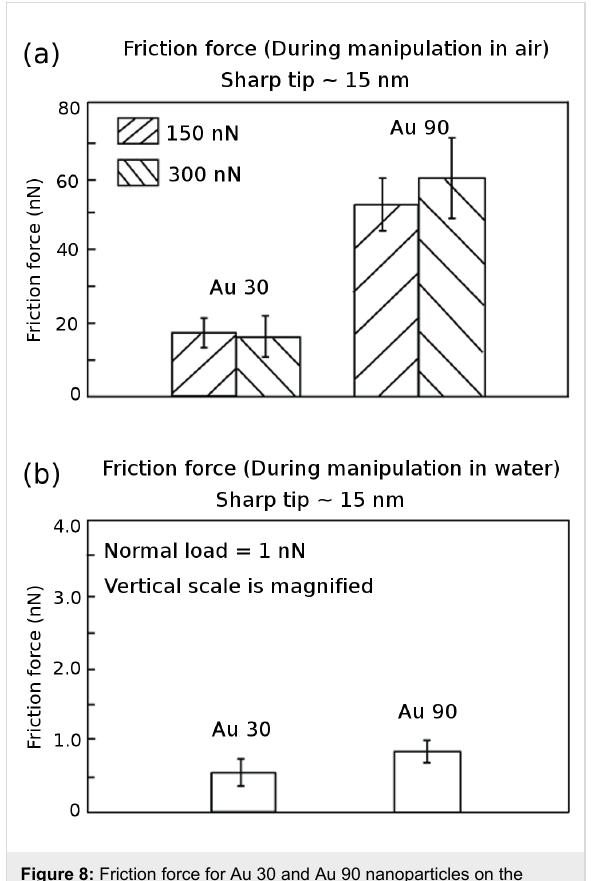
Figure 8: Friction force for Au 30 and Au 90 nanoparticles on the silicon substrate during manipulation, at normal loads of (a) 150 nN and 300 nN in air and (b) 1 nN in water. The vertical scale has been magnified for data in water.